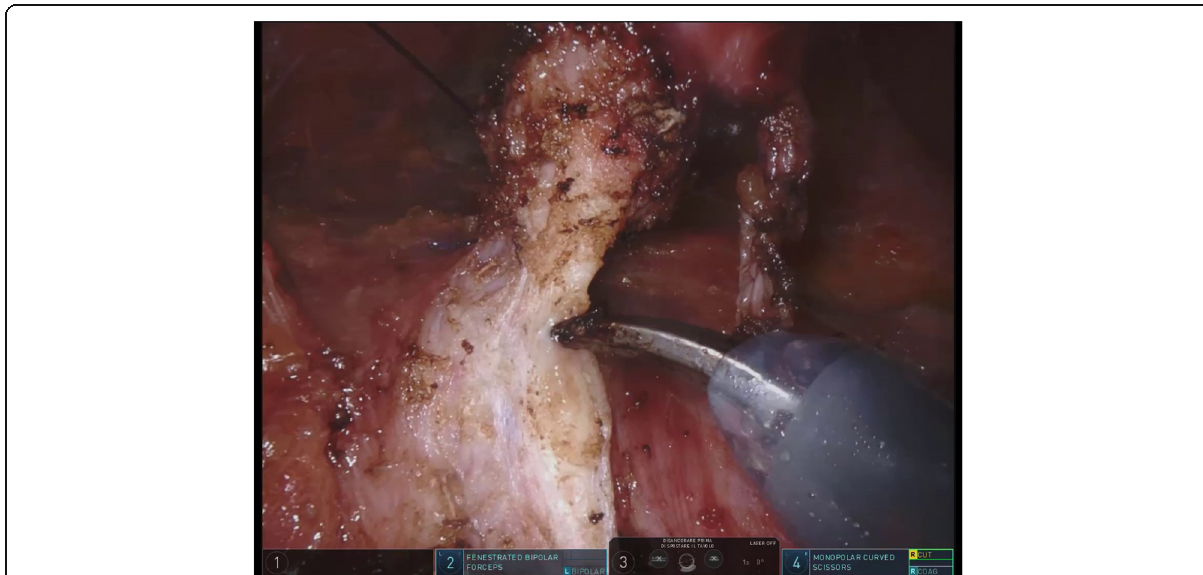
Fig. 2 The urachal cyst during robotic-assisted laparoscopic